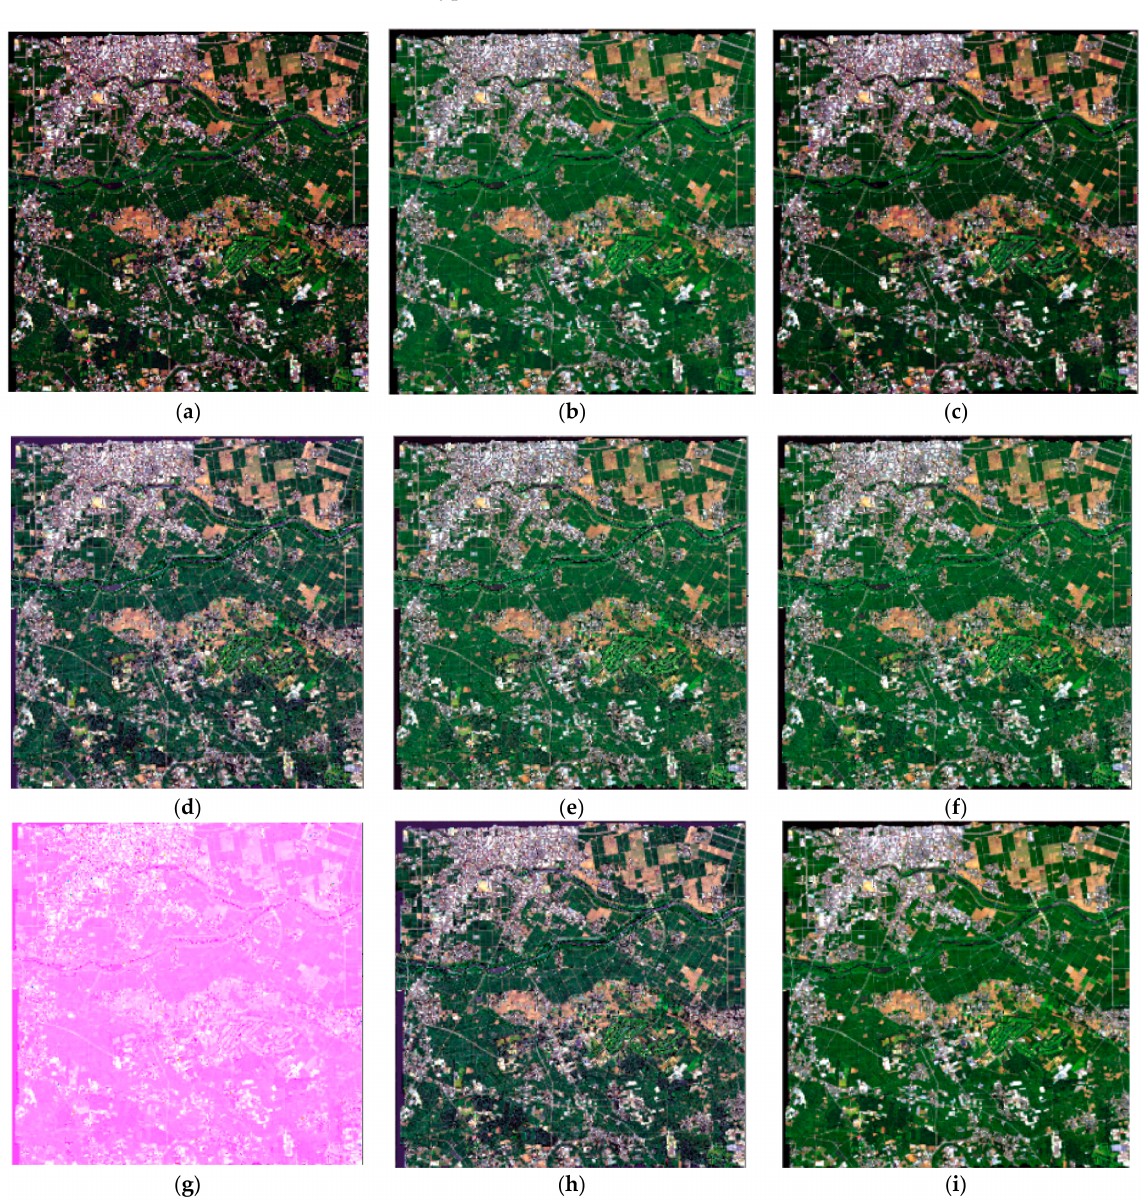
Figure 15. RGB images of ground truth, the different methods and the proposed EDRN method for the Pavia Center dataset: ( a ) Ground truth, ( b ) AWLP, ( c ) CNMF, ( d ) GIHS, ( e ) MTF_GLP, ( f ) HPF, ( g ) SFIM, ( h ) DIP-HyperKite and ( i )